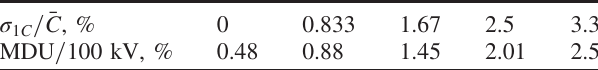
TABLE VI. Flatness of the top of the output pulse of the LTD cavity depending on the tolerance of the capacitor capacitance.